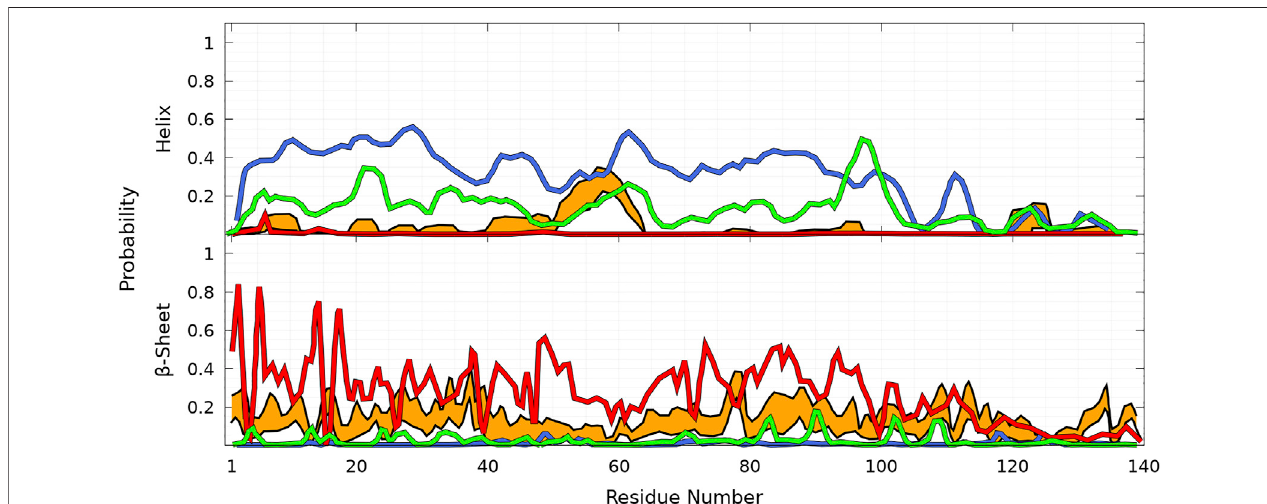
FIGURE 10 | Probability ofeach residue of WT to pertain to an α -helix (top panel) and a β -sheet (bottom panel) as a function of its position in the sequence from MDsimulationsaccordingtofourdifferentworks:Ullmanetal.,2011(orange),Yuetal.,2015(blue),Ramisetal.,2019(red),andCoskunerandWise-Scira,2013(green). The thickness of the orange lines corresponds to the 95% con fi dence interval. Excerpted of the published fi gures of the works cited are reproduced with permissions. Further permissions related to the material excerpted should be directed to the corresponding publishers.